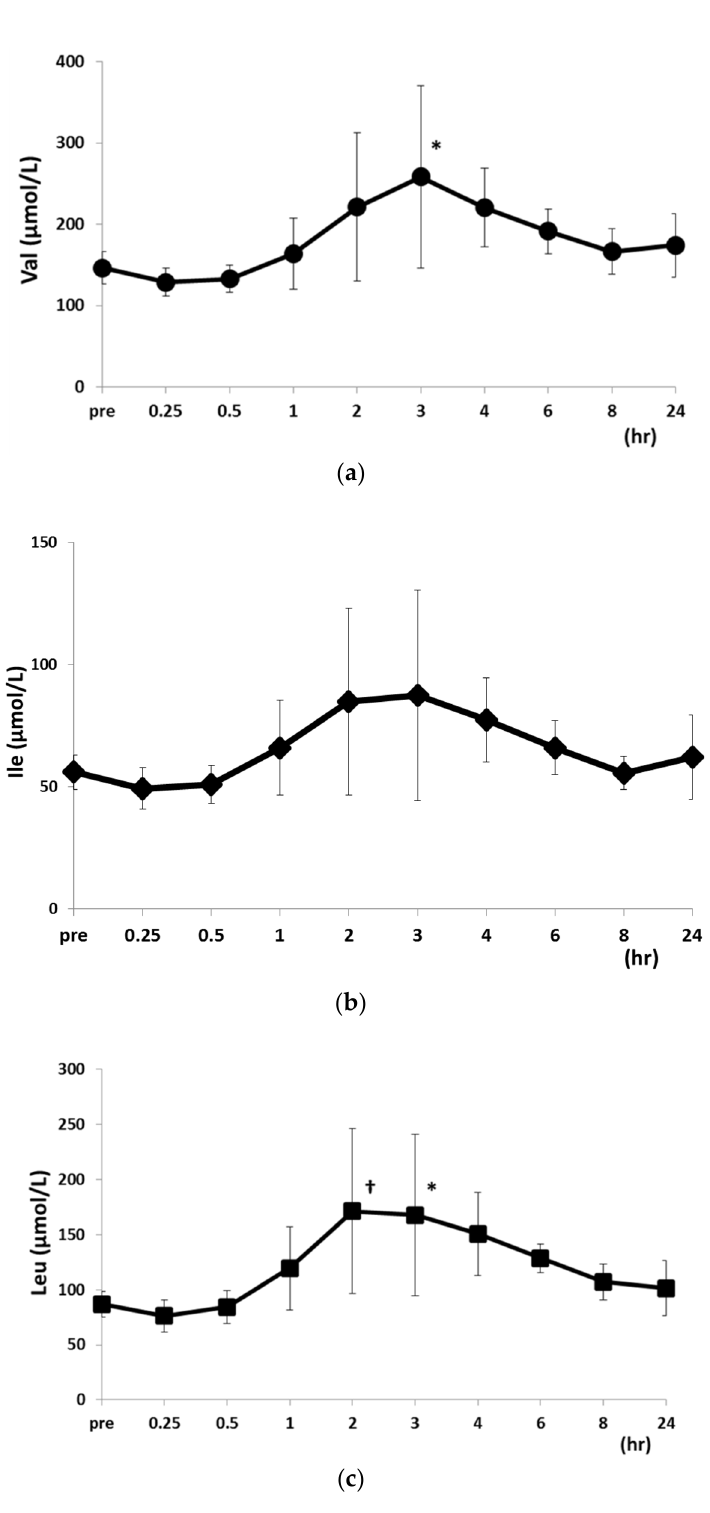
Figure 4. Changes in Val ( a ); Ile ( b ); and Leu ( c ) concentrations after food intake. Data are shown as mean ± SD. * p < 0.05 vs. 15 and 30 min post-food intake. † p < 0.05 vs. pre-food intake.